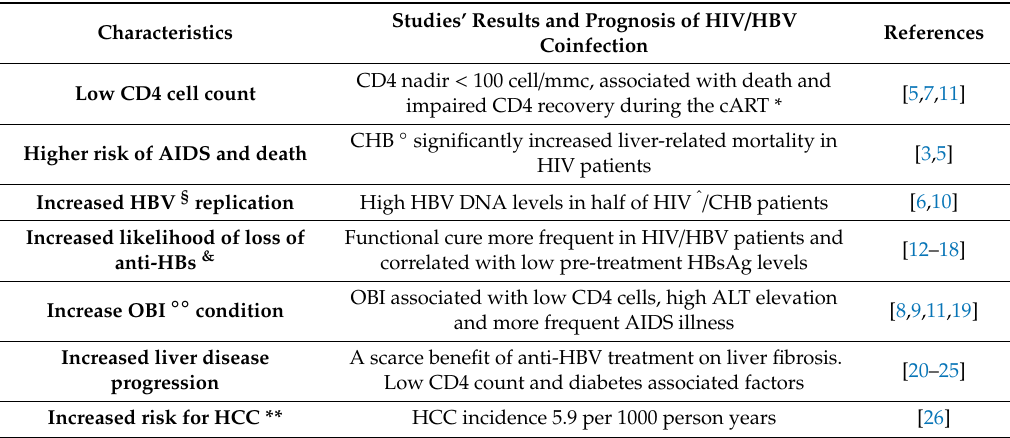
Table 1. Main characteristics of patients with HBV / HIV